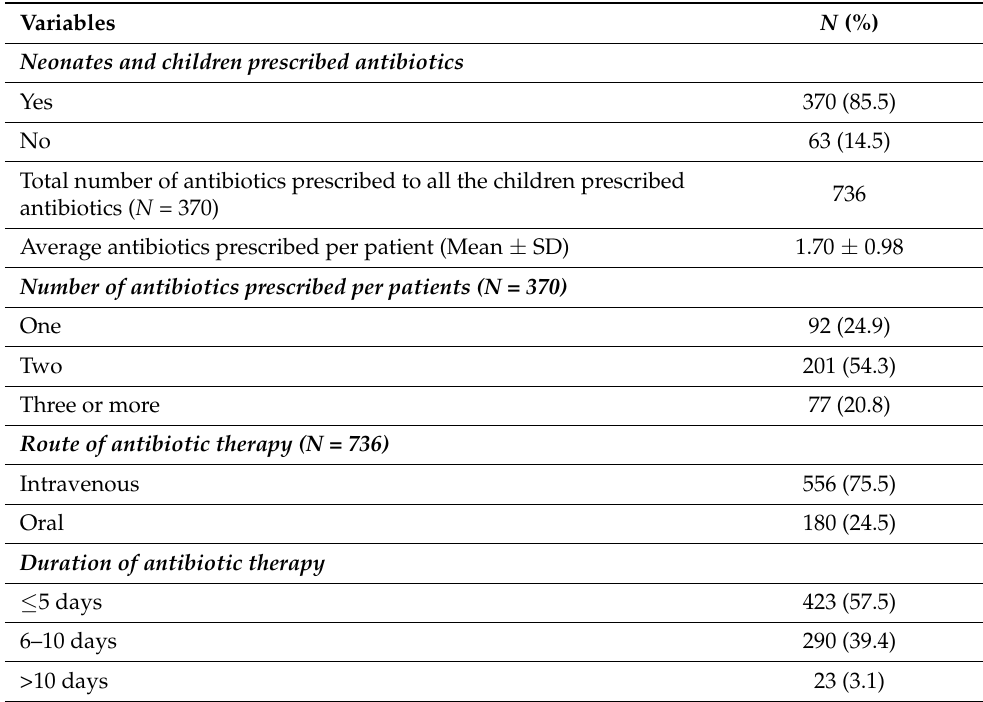
Table 2. Details of antibiotics used in the study population.